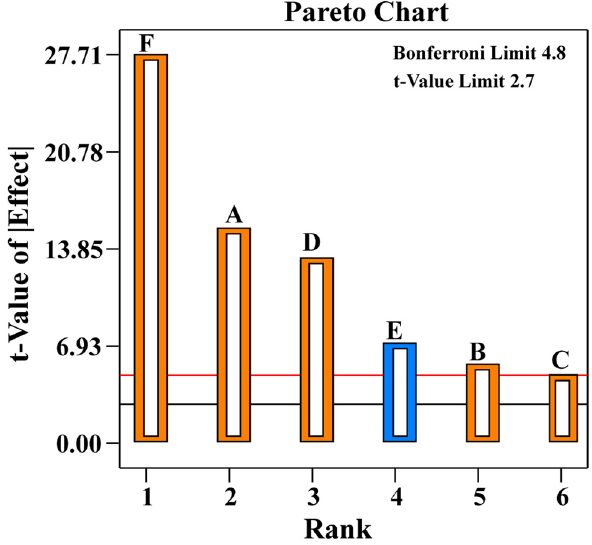
Figure 1: Pareto chart indicating the cumulative e ff ects of indepen - dent variables on Ni 2 + removal by G. amansii biomass using Plackett – Burman design: the orange and blue colors represent the positive and negative independent variables,